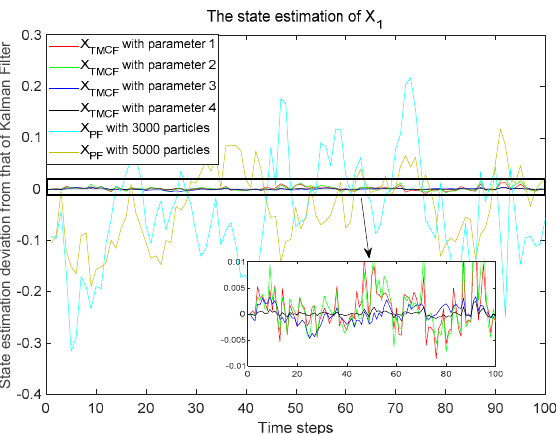
Figure 9. Difference between the state estimation results of the different algorithms and those of KF for x 1 .